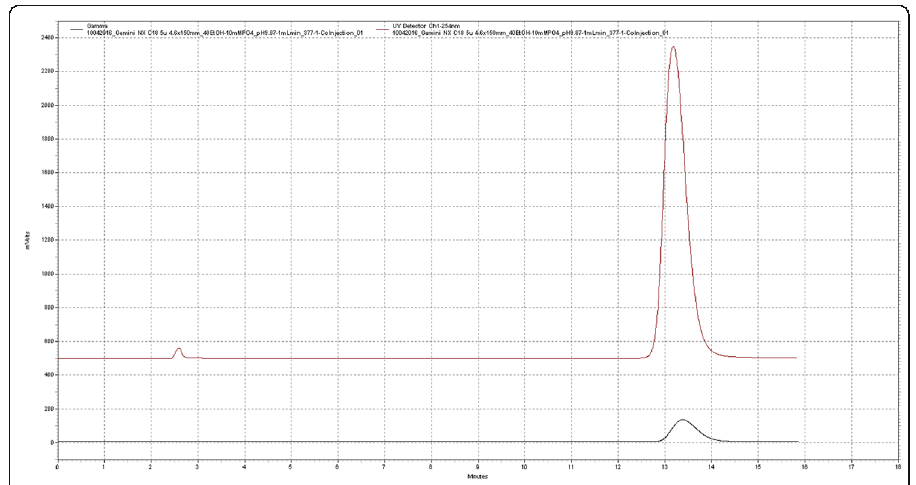
Fig. 3 Typical Analytical HPLC trace of [ 18 F]AV1451: gamma detection trace with overlay of UV trace of genuine standard (Standard UV trace above, Product Radioactivity trace